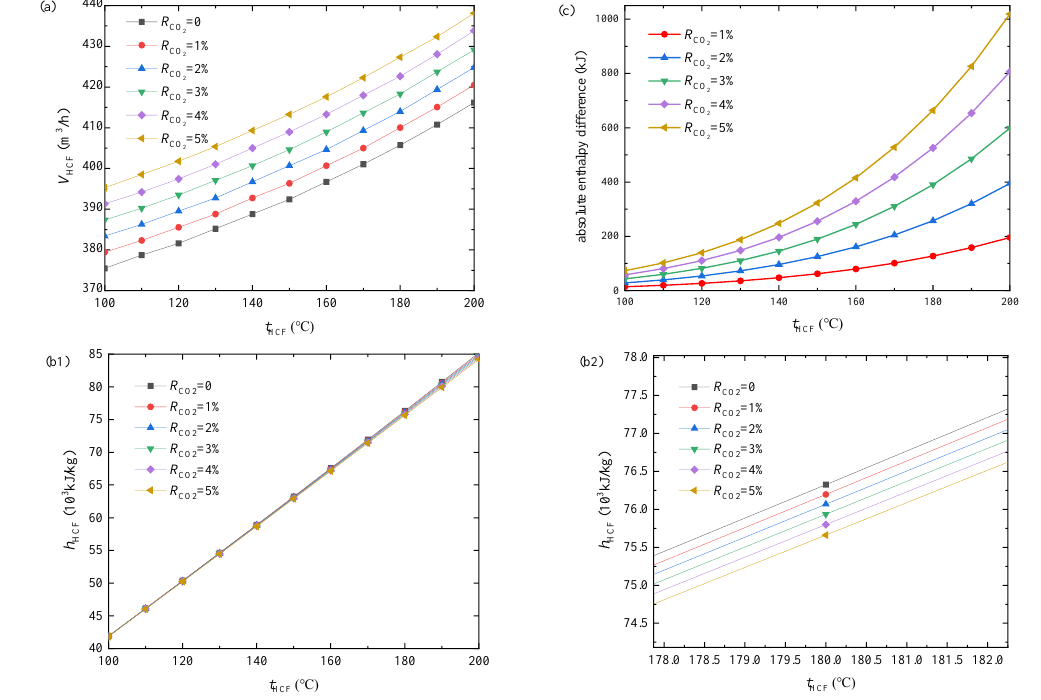
Figure 8. Variation curves of productivity parameters of heat carrier with t HCF under different R CO2 : ( a ) volume flow rate, ( b1 , b2 ) enthalpy and ( c ) absolute enthalpy difference.